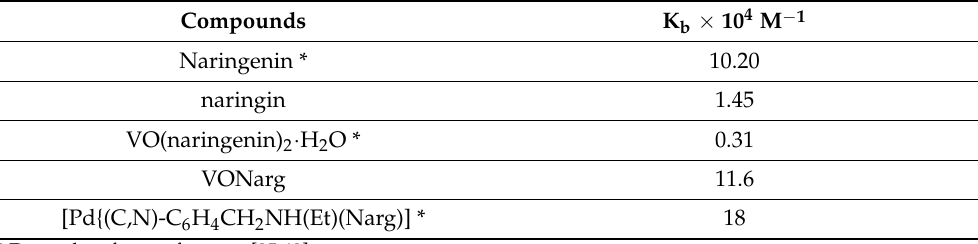
C 6 H 4 CH 2 NH(Et)(Narg)] complexes at 298